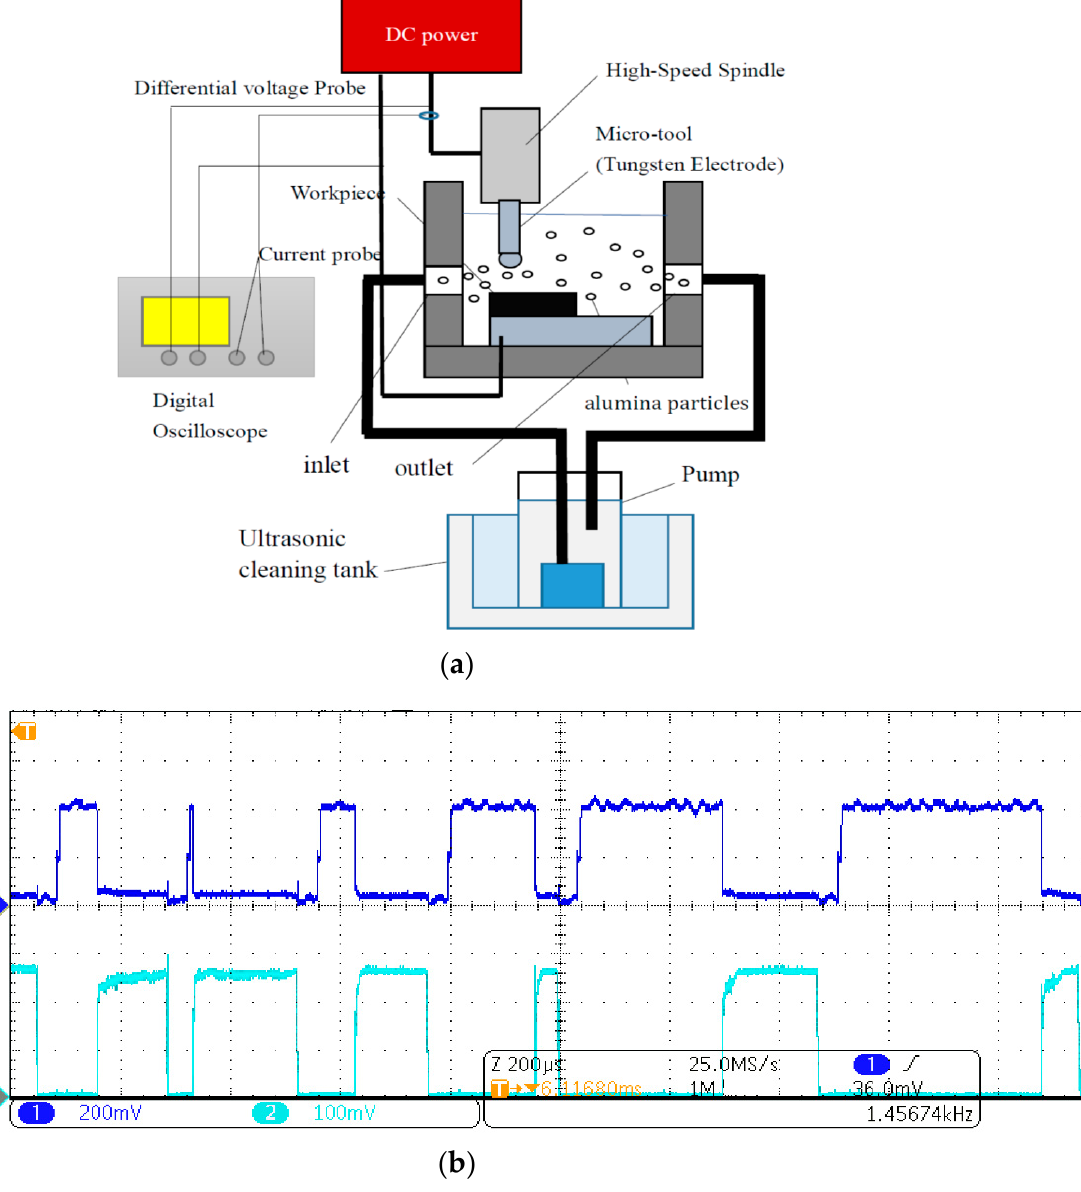
Figure 4. ( a ) Setup of the DI-water ECM tanks and hybrid abrasive ECM; ( b ) typical pulse waveform of the DC power supply. CH1: Voltage (V) × 1/150, CH2: Current (mA) × 1/180. Table 1. Operational conditions of ECM with a tank retrofitted from the micro-EDM machine. Feed Rate ( μ m/min)